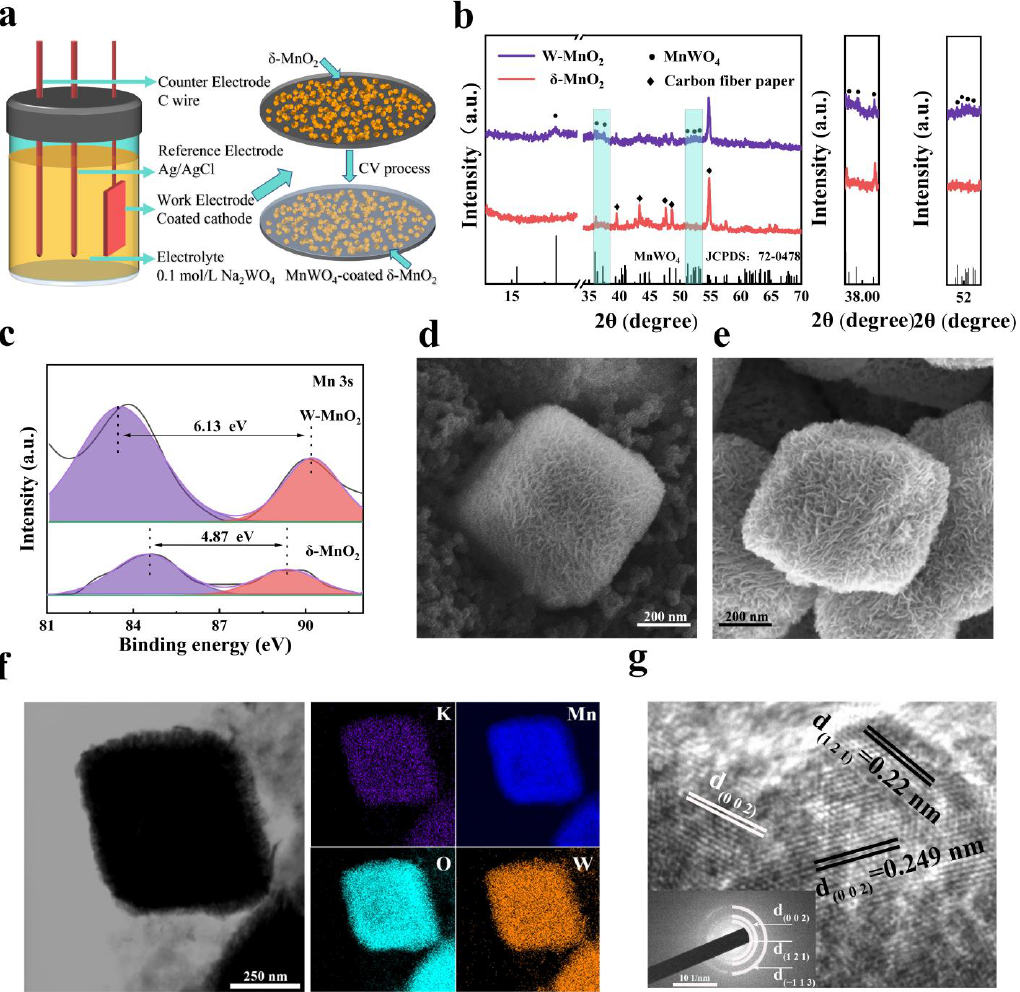
Figure 1. ( a ) Schematic illustration of the preparation process of MnWO 4 CEI layer. ( b ) XRD patterns of δ-MnO 2 and W-MnO 2 . ( c ) High-resolution XPS spectra of Mn 3s region in δ-MnO 2 and W-MnO 2 . ( d , e ) The morphology of ( d ) δ-MnO 2 and ( e ) W-MnO 2 . ( f ) TEM image and the elemental mappings of W-MnO 2 . ( g ) HRTEM image of MnWO 4 on the surface of W-MnO 2 and the corresponding SAED pattern (inset).